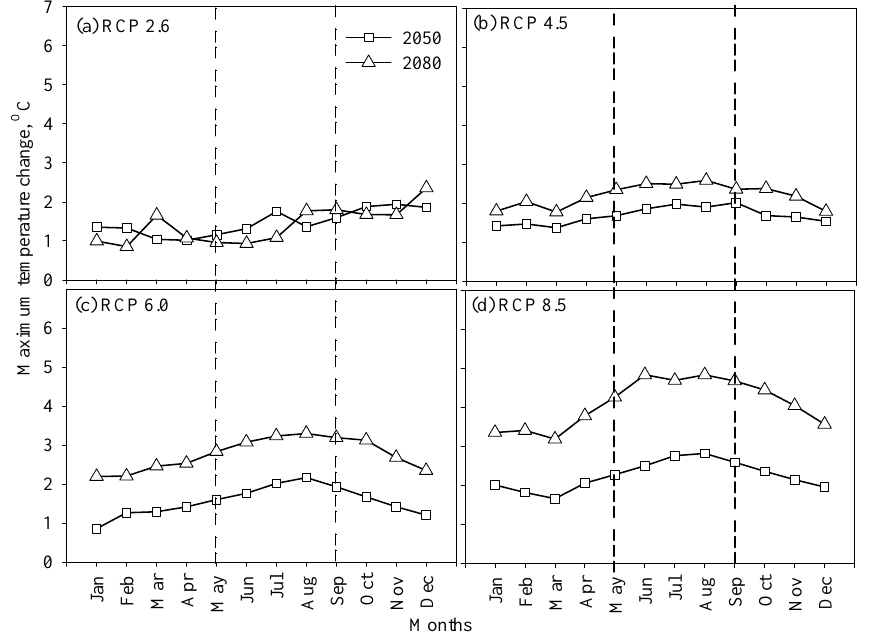
Figure 3. Coupled Model Inter-comparison Project Phase 5 (CMIP5) multi-climate model ensemble projected maximum temperature changes at Stoneville, MS, for the four emissions scenarios of the Representative Concentration Pathways (RCPs), RCP 2.6 ( a ), 4.5 ( b ), 6.0 ( c ), and 8.5 ( d ), as used in the IPCC Fifth Assessment Report. Dotted lines in the vertical demarcate the normal cotton growth season (May to September).